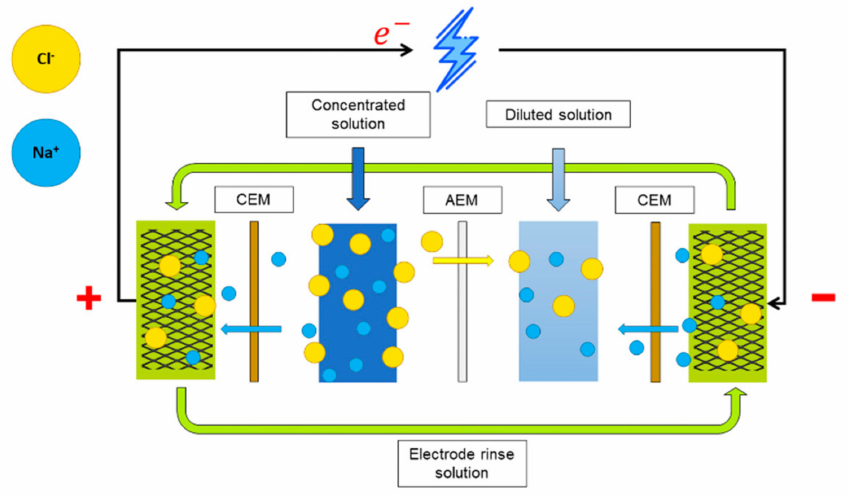
Figure 1. Diagram of an RED